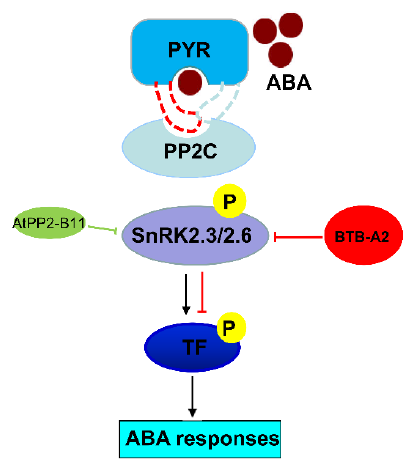
Figure 8. A propose model of Arabidopsis BTB-A2s regulating ABA signaling.